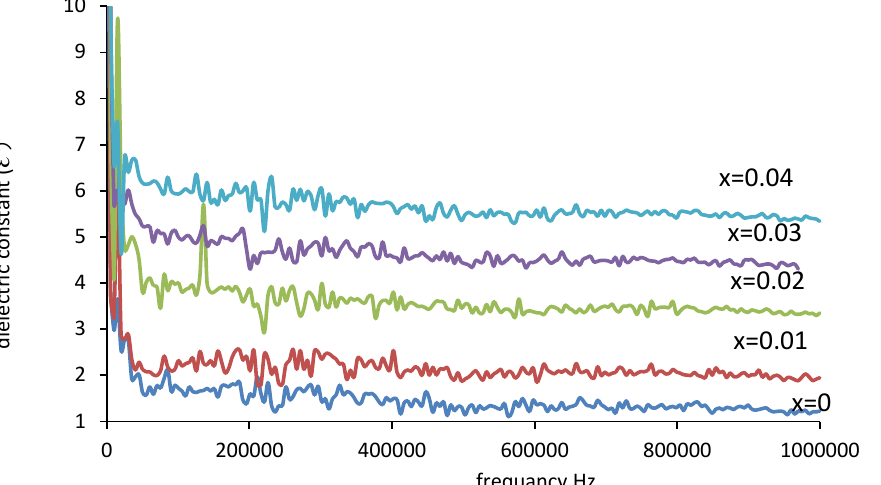
Fig. 7: Dielectric constant as a function of frequency for Ni